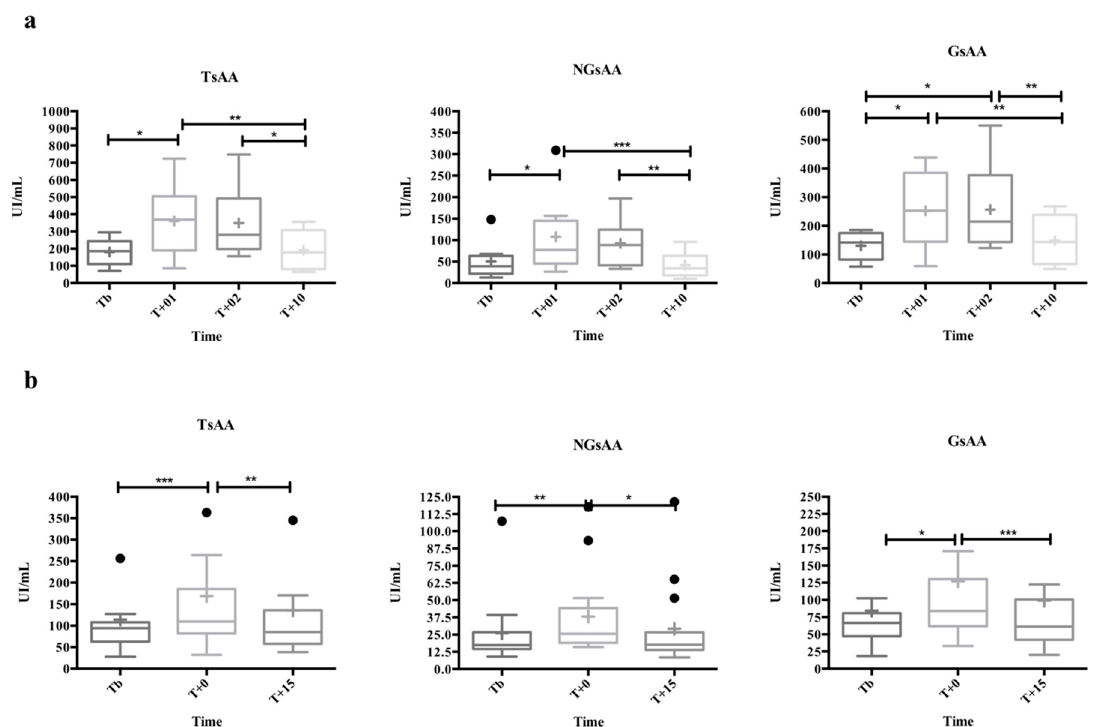
Figure 3. Total non-glycosylated and glycosylated sAA (TsAA, NGsAA, and GsAA, respectively) activity results in two different stimulation models. ( a ) Physical effort ( n = 8), based on a CrossFit WOD, five min before the exercise (Tb), between rounds of WOD2 (T + 01), after completion of the exercise (T + 02), and 10 min after (T + 10). ( b ) Psychological challenge ( n = 18), based on the standardized Trier Social Stress Test (TSST), 5 min before the test (Tb), just after (T + 0), and 15 min later (T + 15). The plot shows median (line within box), 25th and 75th percentiles (box), 5th and 95th percentiles (whiskers), and outliers (•). The cross inside the box shows the mean. Asterisks indicate significant post hoc difference (Dunn’s multiple comparisons test) with respect to the previous time: * p < 0.05; ** p < 0.01; *** p < 0.001.